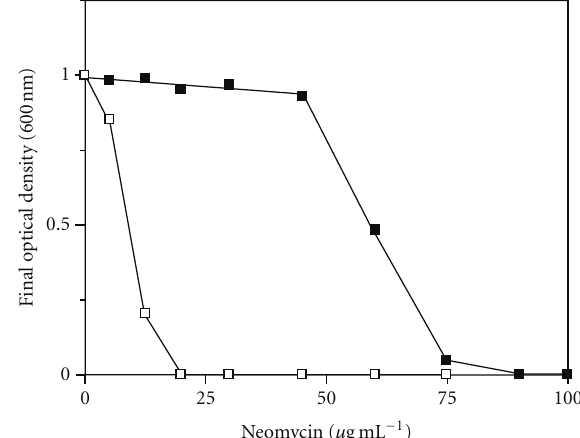
Figure 4: Growth behavior of 5mL Ms. mazei cultures with di ff erent concentrations of neomycin. ( (cid:2) ) Cultures harboring the pWM321-neo plasmid. ( (cid:3) ) Cultures without an additional